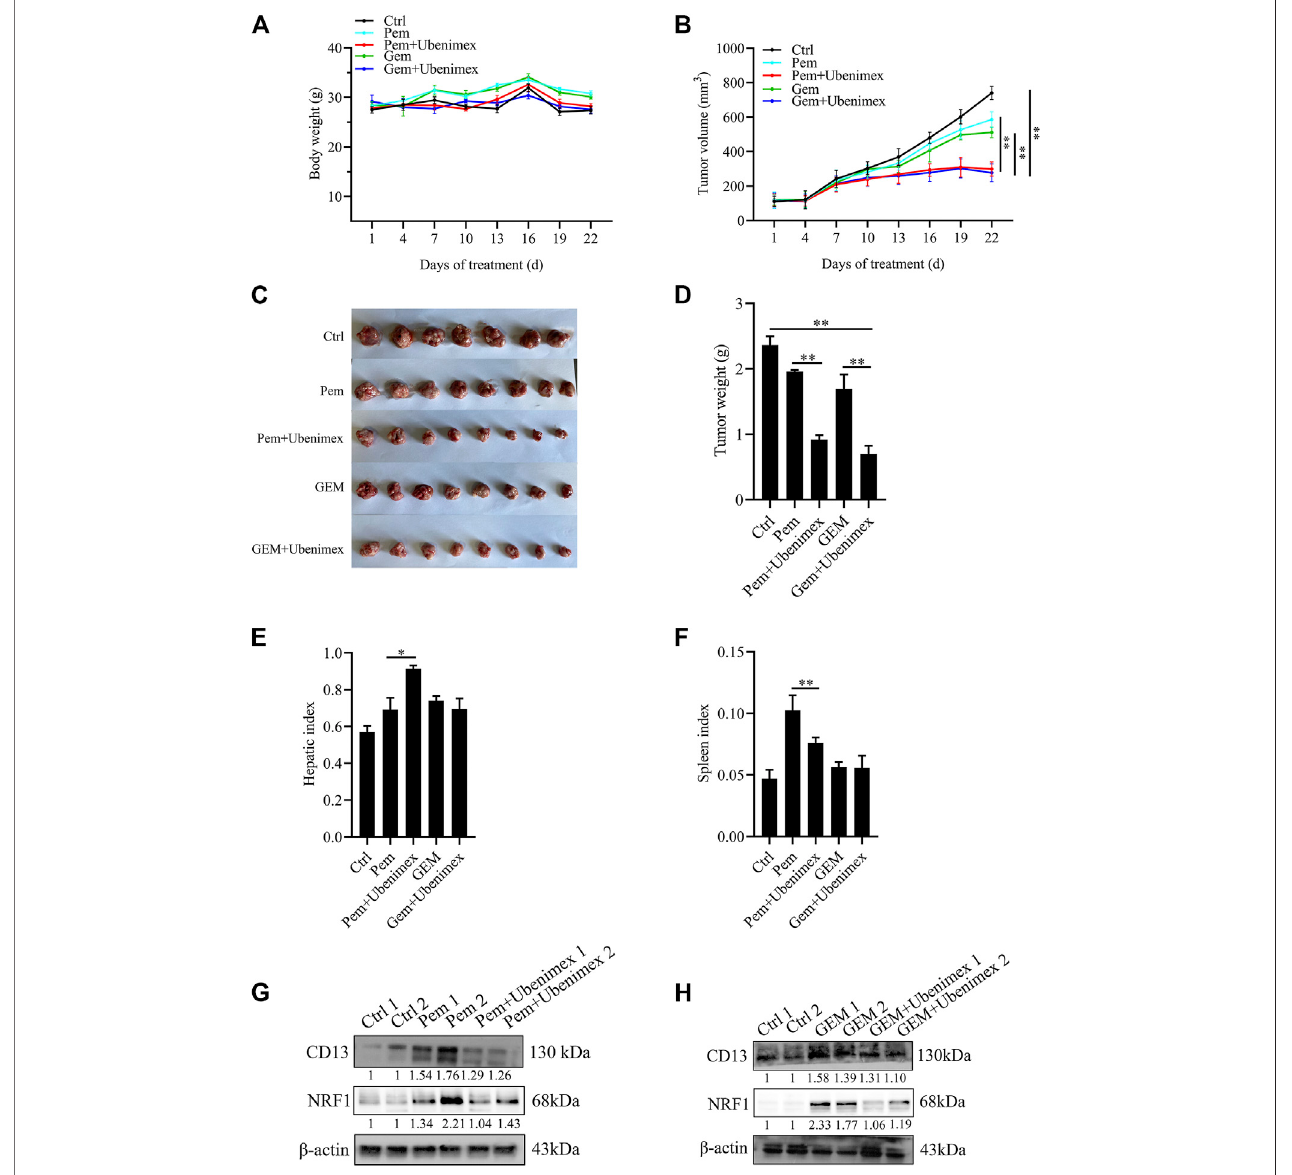
FIGURE 6 | Combination of ubenimex and 5FU suppresses tumor growth in vivo . (A,B) Body weight and tumor volumes of mice with different drug treatment. (C – F) Tumortissue,liverandspleentissueofmicewereweighed.Dataarepresentedasmean ± SEM.* p ≤ 0.05,** p ≤ 0.01. (G,H) Immunoblottingonproteinexpression in tumors treated with Pem, or GEM, ubenimex + Pem, and ubenimex + GEM. β -actin was the protein loading control.